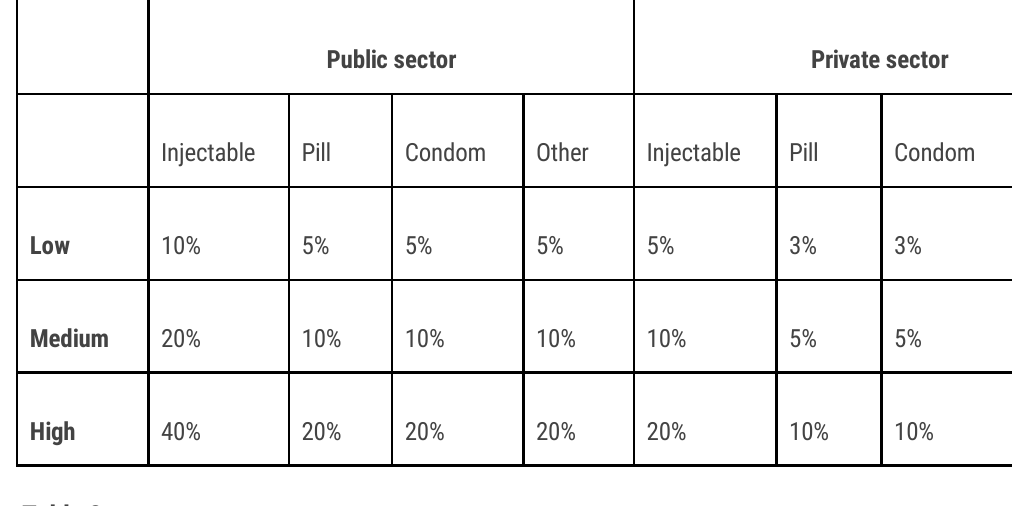
Average unintended pregnancy averted per